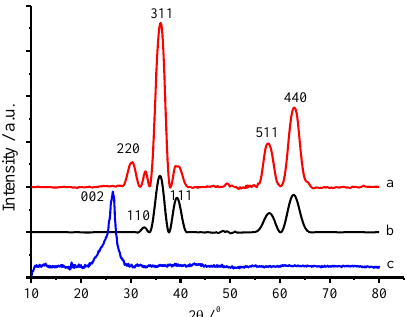
Figure 2. XRD patterns of the as-prepared CuFe 2 O 4 /NG ( a ), CuFe 2 O 4 ( b ) and NG ( c ) samples.